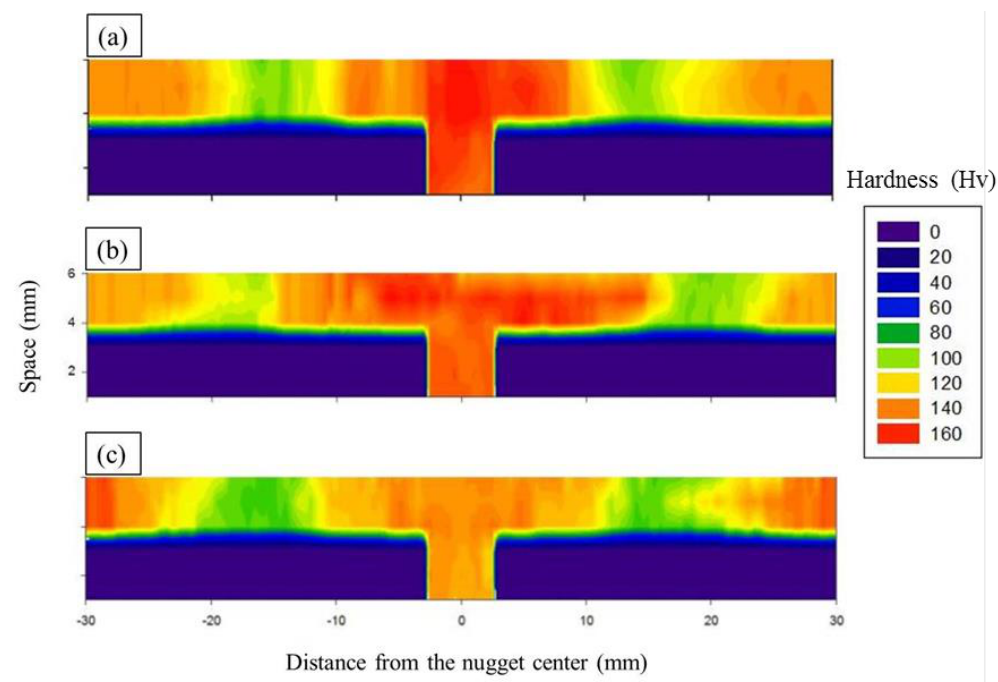
Figure 7. Hardness maps of the T-butt joint AA2024-T4 and AA7075-T6 friction stir welded at different rotational speeds of ( a ) 400 rpm, ( b ) 600 rpm and ( c ) 800 rpm.